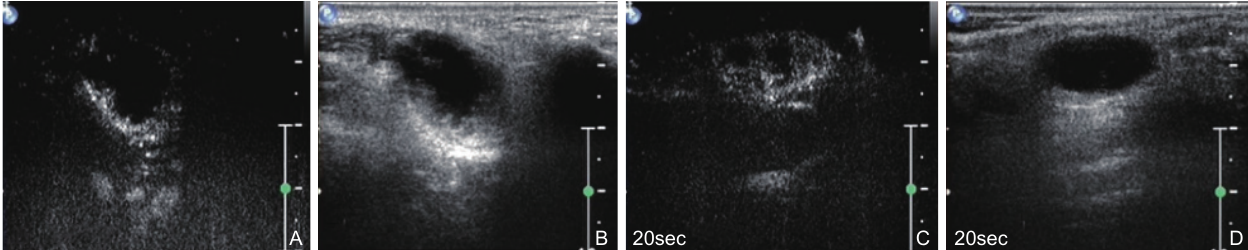
Figure 2 Contrast-enhanced US of the nodule in the bilateral parotid before MWA. (A, B) The solid area of the inner wall of the right nodule was rapidly and highly enhanced; (C, D) Most of the left nodule were enhanced and some areas in the center were not.